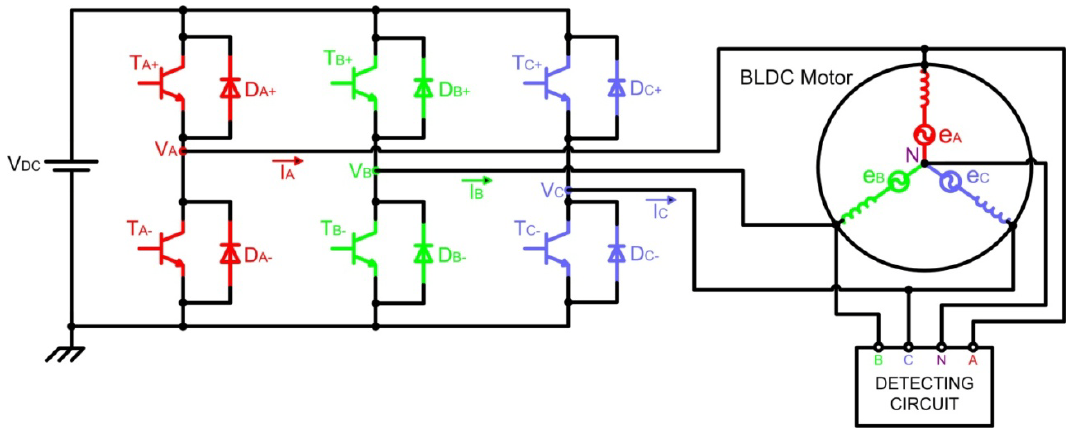
Figure 7. Typical sensorless BLDC motor drive [19].